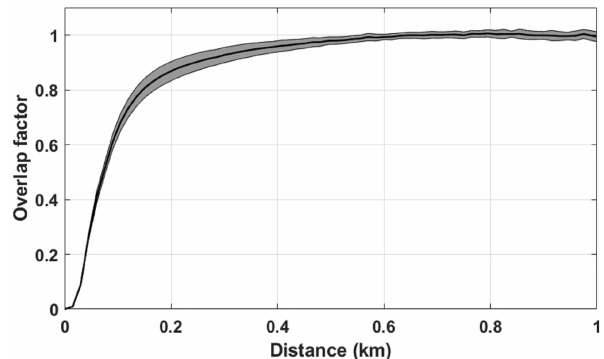
Figure A1. Overlap factor of the ALS (continuous black line) and its standard deviation (grey